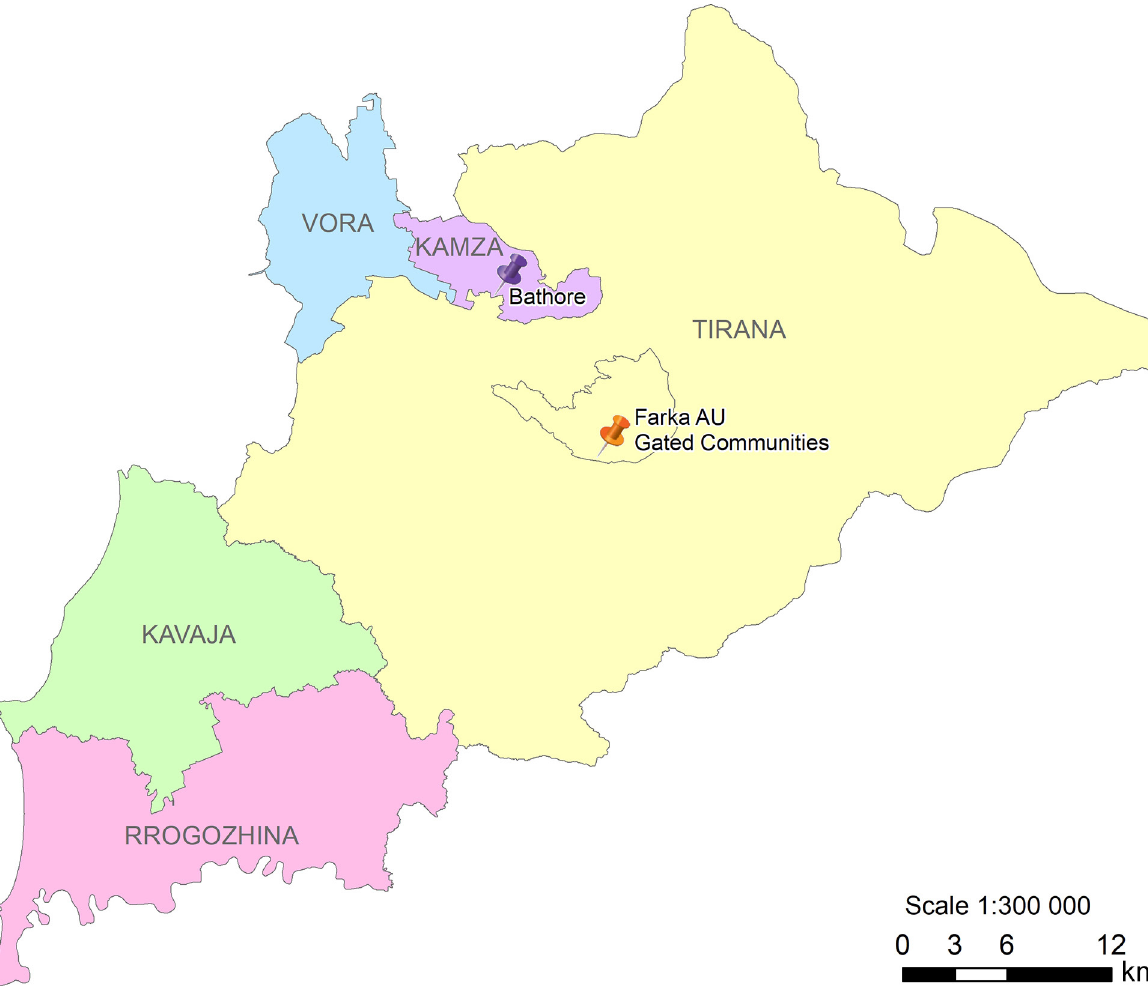
Fig. 1. kamza and Farka AU in the Tirana city